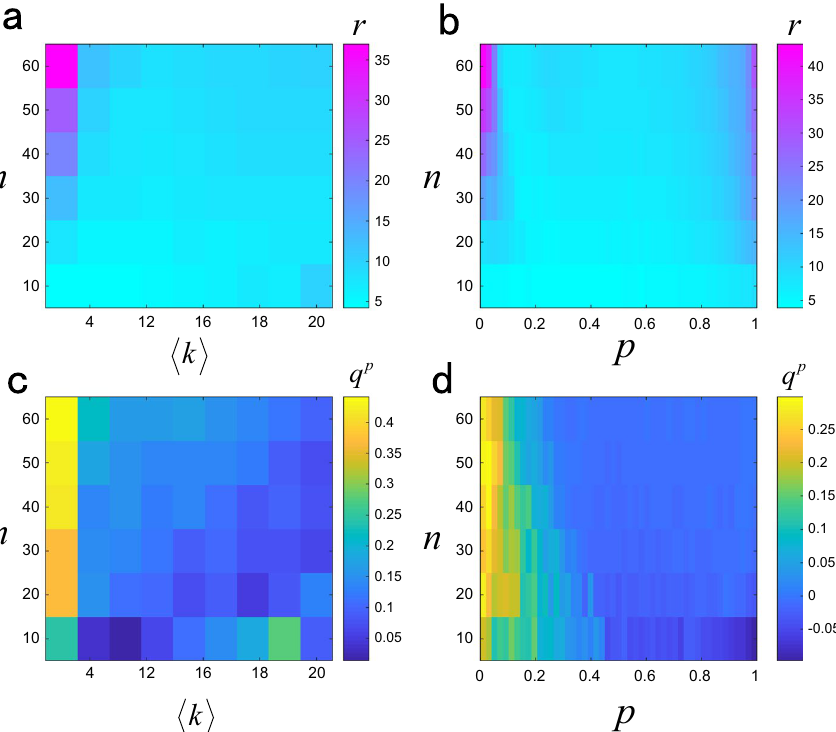
Figure 9. Relationship between locatability and network parameters. ( a ), ( b ) are relationship between the number of locatability observer nodes and network parameters on BA and ER networks respectively. The abscissa is the average degree of the network in ( a ) and the adding link probability in (b), ordinate is network size n , and the colors in heat map are the number of locatability observer nodes. ( c ), ( d ) are relationship between measurement index q p of locatability observer nodes and network parameters. The colors in heat map are the measurement index q p . ( c ) is BA and ( d ) is ER